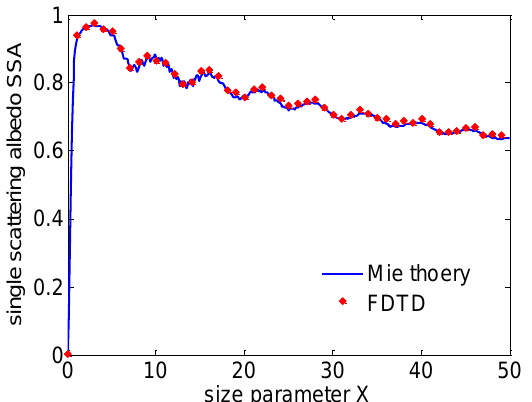
Figure 5. Comparison of the extinction coefficient, absorption coefficient and single scattering albedo simulated by Mie scattering theory and parallel FDTD